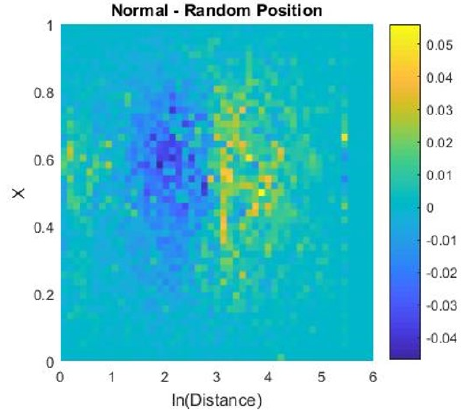
Figure 14: Normal heat map - heat map of hit points resulting from shuffled gaze vectors (One subject). It shows a systematic bias for bigger